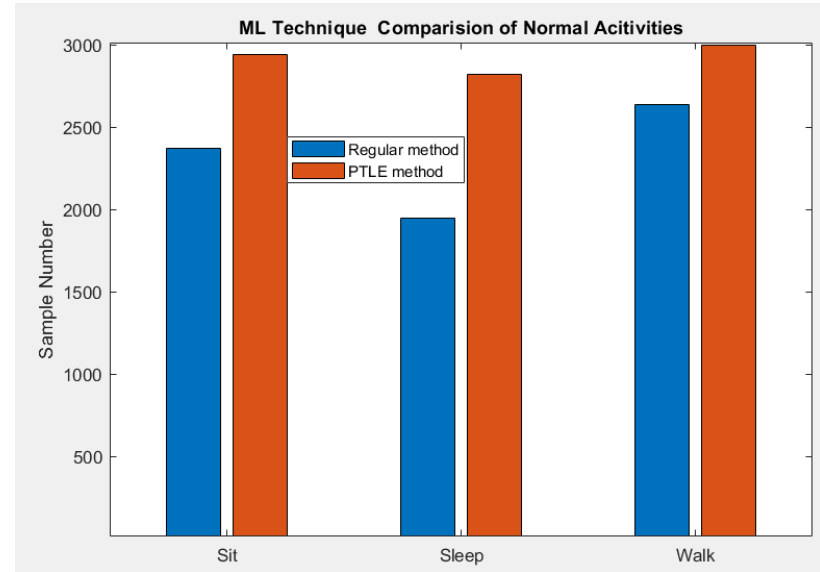
Figure 9. Correct prediction from the two methods in normal activities.